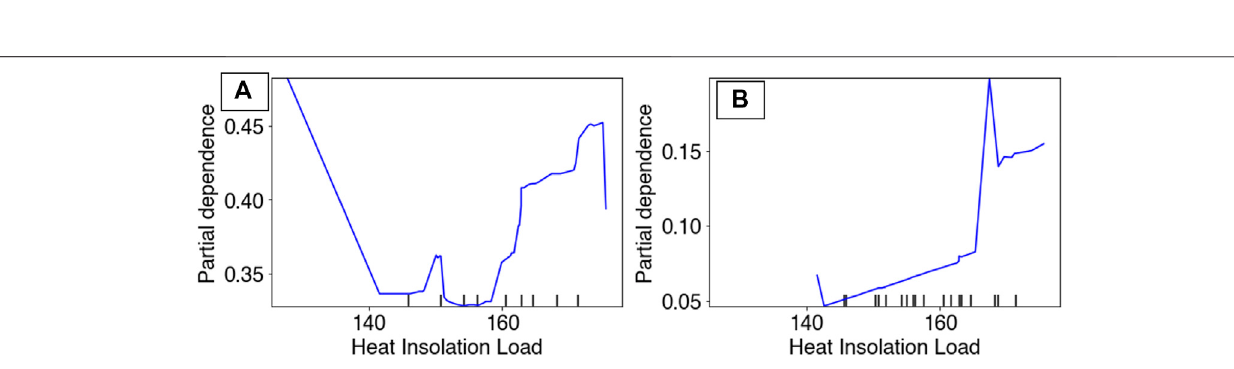
Frontiers in Big Data |